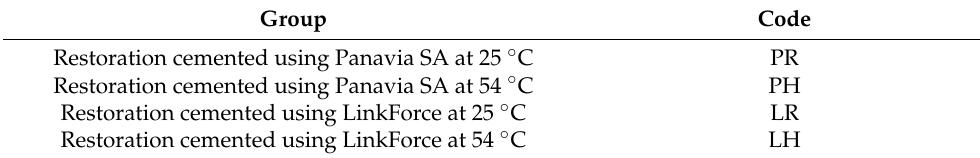
Table 1. The study Table 1. The study groups.